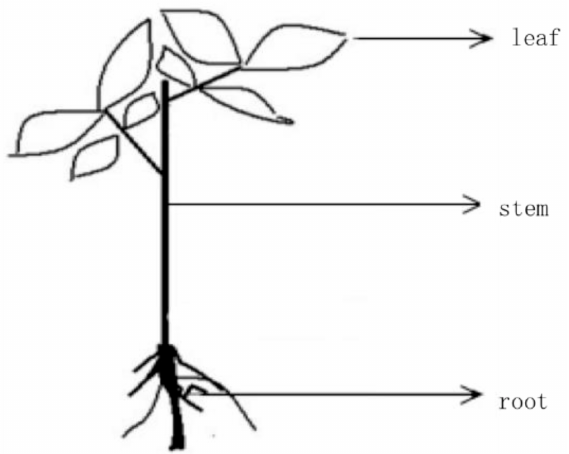
Figure 5. Schematic diagram of the peanut plant sampling.